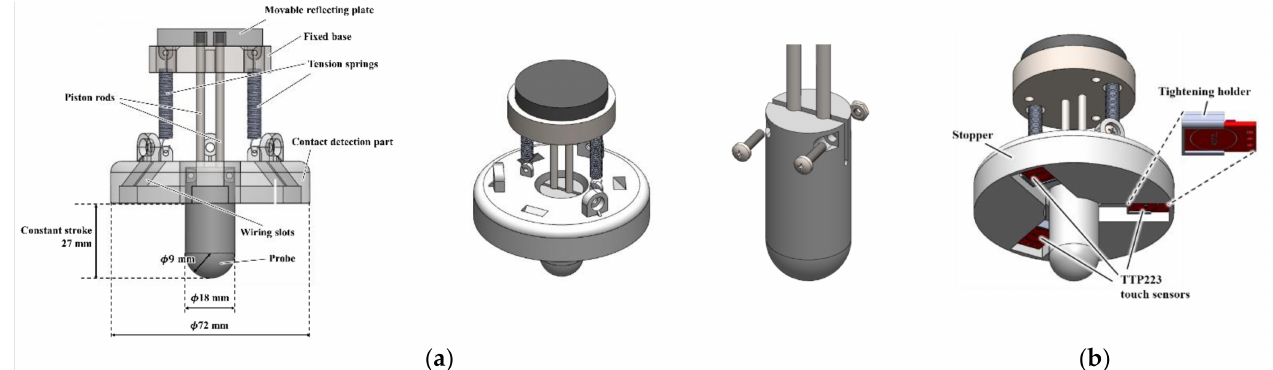
Figure 4. Structure of bottom parts: ( a ) Mechanical transmission structure of the probe. ( b ) Contact detecting